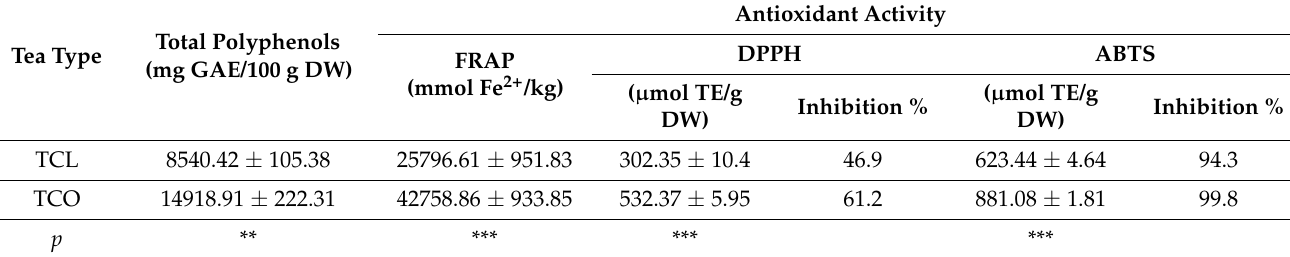
Table 2. Total polyphenols, and antioxidant activity of Tea Compagnia del Lago (TCL) and Tea Camellia d’Oro (TCO). Data are presented as mean value ± standard